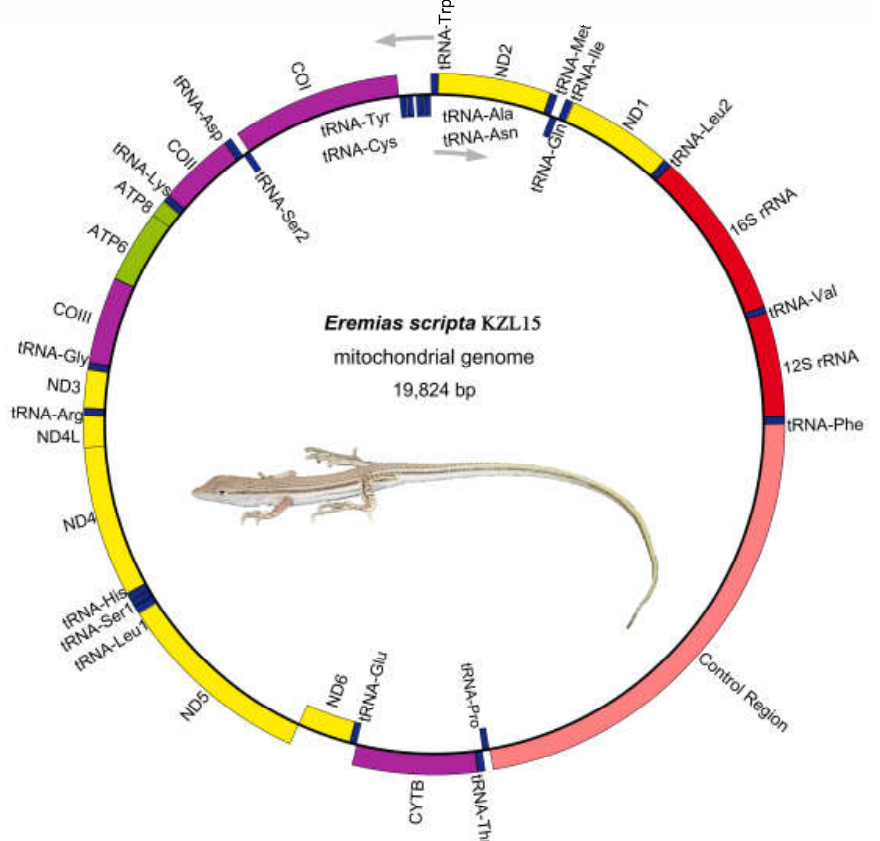
Figure 1. Mitochondrial genome map of E. scripta KZL15. Genes encoded by the light or heavy strand are indicated inside or outside, respectively, showing the direction of transcription. The tRNAs are denoted by color blue and labeled according to the three-letter amino acid codes. The mitogenome maps of E. scripta KZL44, E. nikolskii , E. szczerbaki, and E. yarkandensis are similar to that of E. scripta KZL15. Lizard photo by Xianguang Guo.